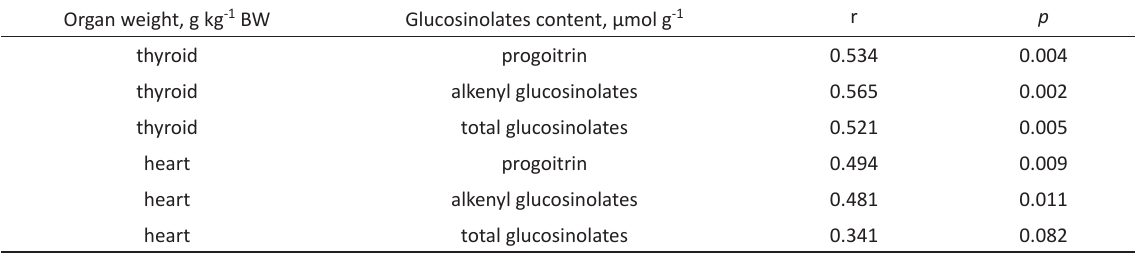
Table 8. Relationship between the content of glucosinolates in diets (µmol g -1 ) and the relative weight of thyroid and heart (g kg